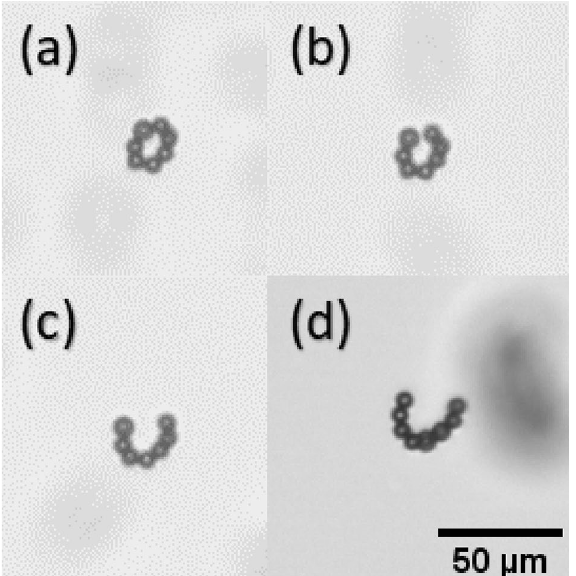
Figure 4. Maximum observed filament deformation within one period for different filaments. In ( a – c ) L = 48 µ m, H = 5.2 Oe and f = 4 − 6 Hz. In ( d ) L = 53 µ m at fixed f = 4 Hz and H = 5.2